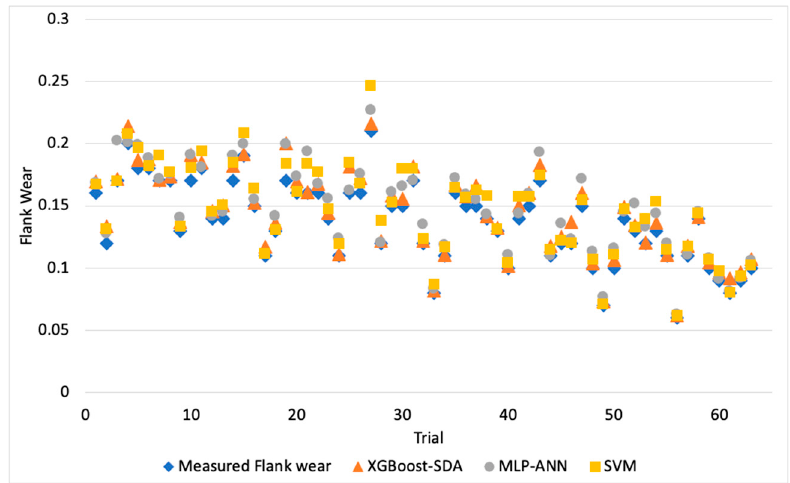
Figure 6. Flank wear values vs. predicted flank wear values of a drilling process (Cast Iron Workpiece).